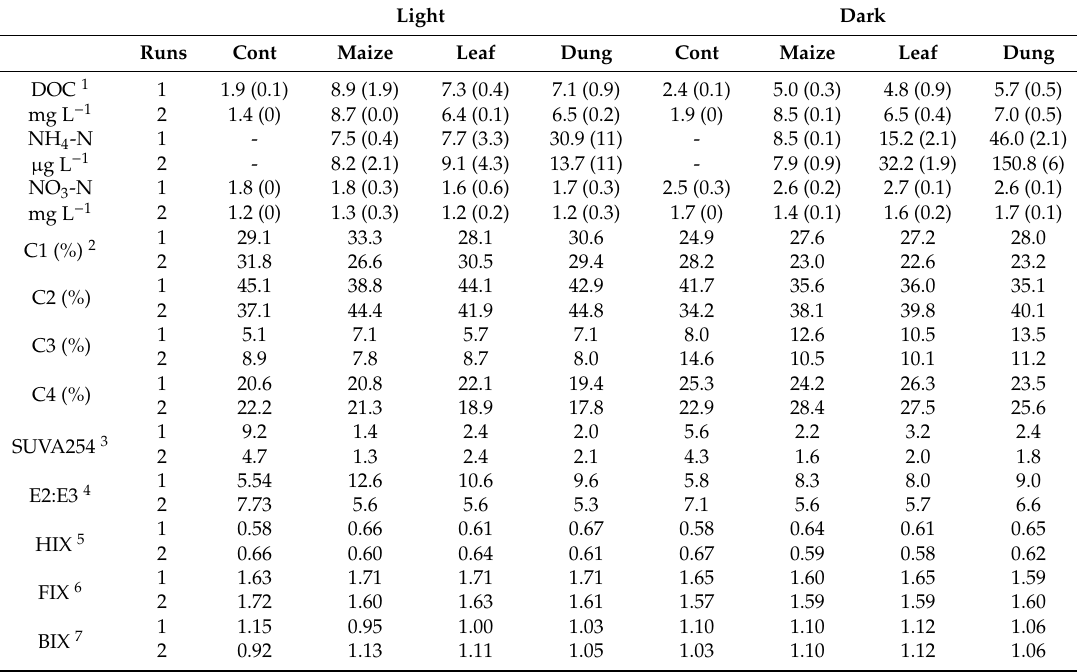
Table 2. Initial water chemistry and selected spectroscopic data of the flume water four hours after the leachate additions (Cont = control flumes; maize, leaf, and dung = flumes with leachate additions of these sources; - below detection limit; means and standard deviations in